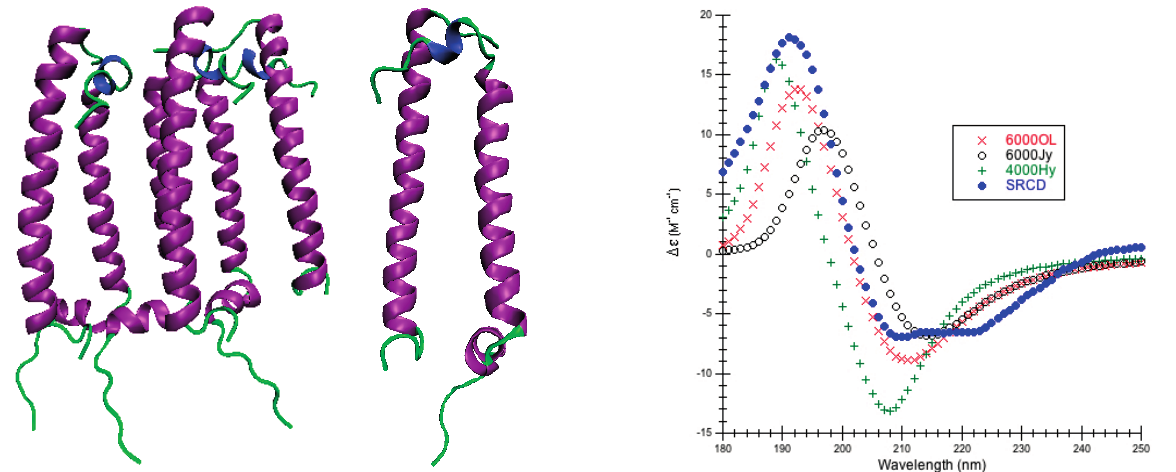
Figure 6. Light-Harvesting Protein Complex II. ( Left & Center ) Secondary structure of light-harvesting protein complex II (PDB code 1NKZ [67]). The purple coils are helices (12–37, 40–46); the 3 10 -helices are blue (6–8). The green coils are other structures. ( Left ) Asymmetric unit (A 3 B 3 ); ( Center ) Heterodimer (AB). ( Right ) Predicted CD